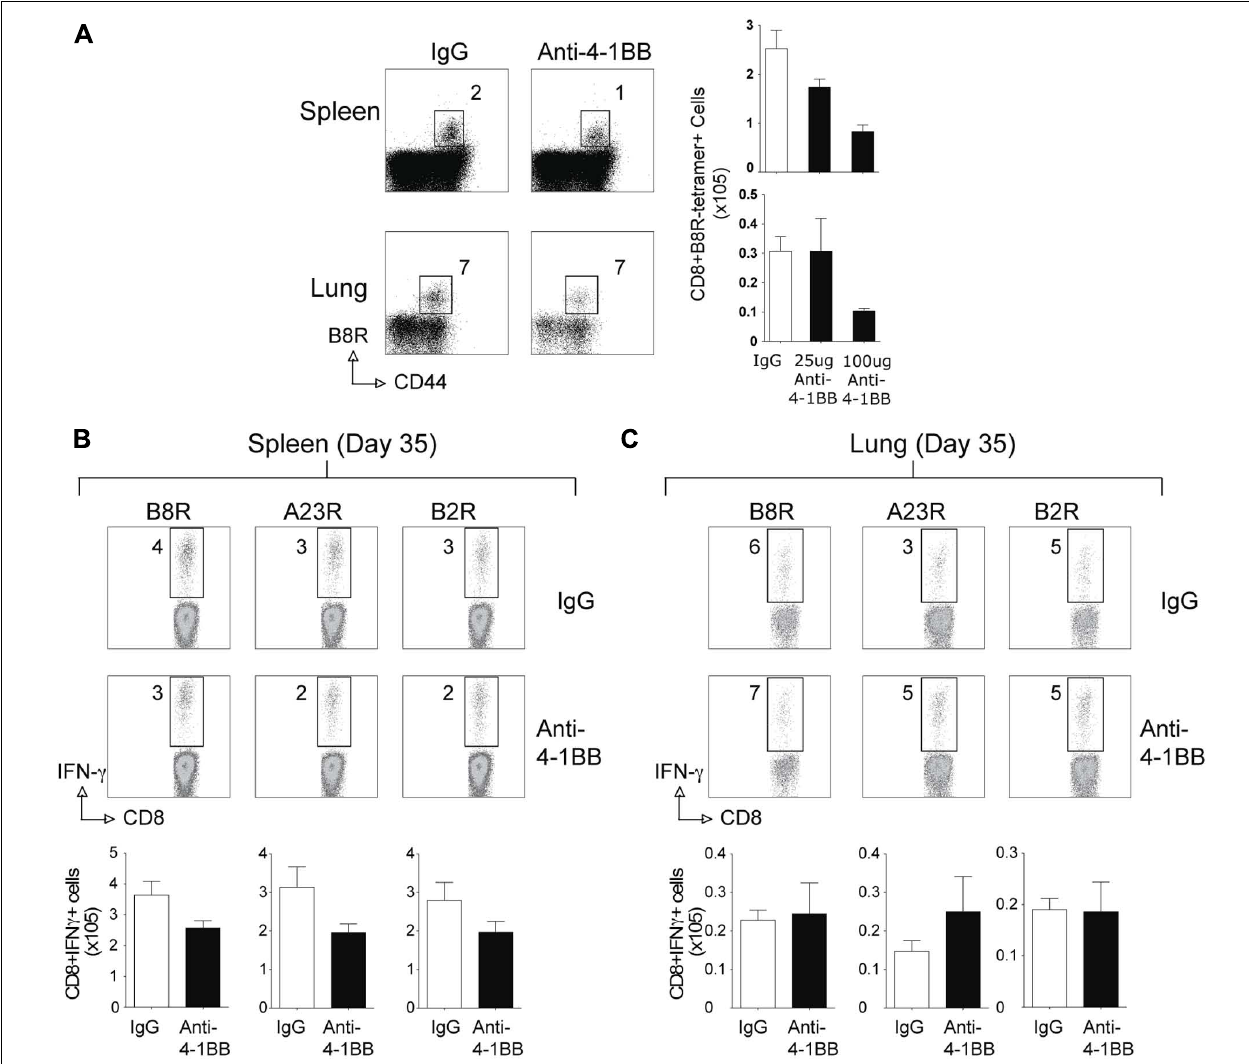
FIGURE 4 |Anti-4-1BB treatment does not enhance CD8T cell memory toVACV-Lister. Mice were infected i.p. with 2.5 × 10 5 PFU/ mouse ofVACV-Lister. One day later, mice were treated with 25 μ g (A–C) or 100 μ g (A) of control rat IgG or anti-4-1BB and responses assessed after 35 days. (A) Spleen (upper panel) and lung (lower panel) cells were stained with CD8, CD44, and B8R tetramer (left).Total numbers of CD8 + B8R-tetramer-positive cells in spleens (right). (B,C) CD8T cell